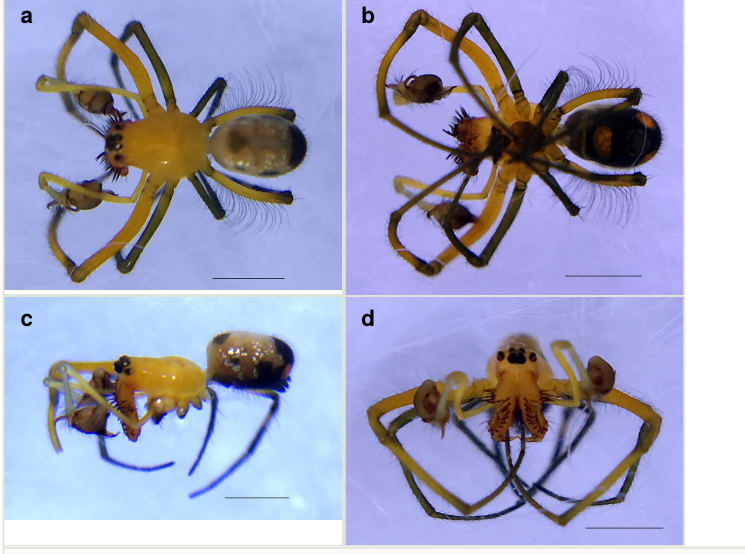
Male Opadometa sarawakensis Dzulhelmi & Suriyanti, 2015 (DGFCW2018022300), somatic morphology. a : Dorsal view. Scale bar 1 mm. b : Ventral view. Scale bar 1 mm. c : Left lateral view. Scale bar 1 mm. d : Frontal view. Scale bar 1